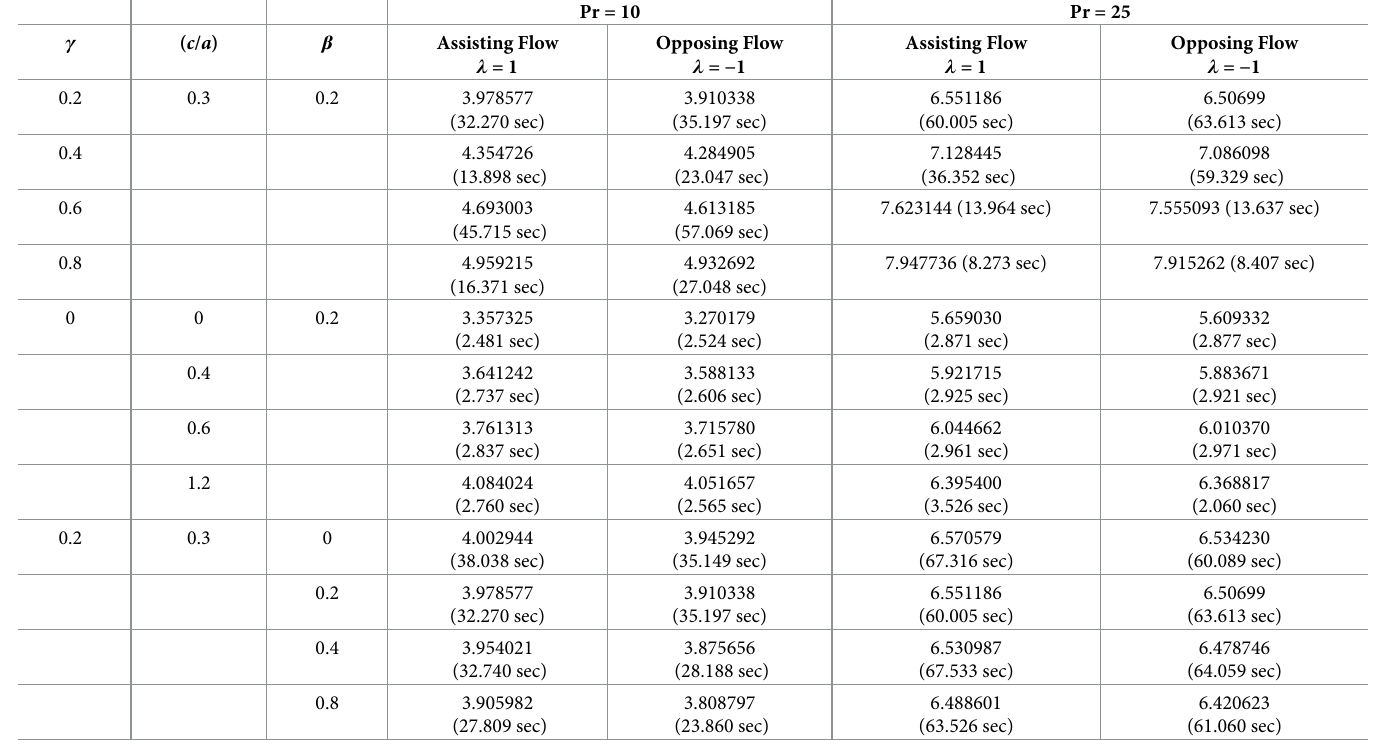
Table 4. Computational results of − θ 0 (0) for varying values of γ ,( c / a )and β with Pr = 10 and M =